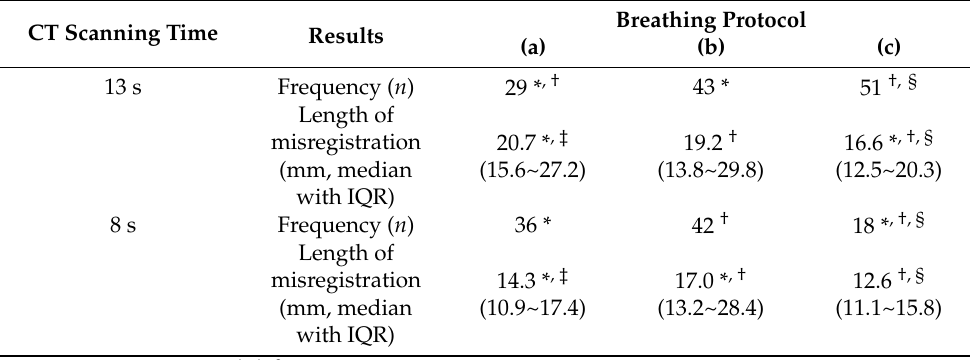
Table 5. The frequency of PET/CT misregistrations and their lengths according to breathing protocol